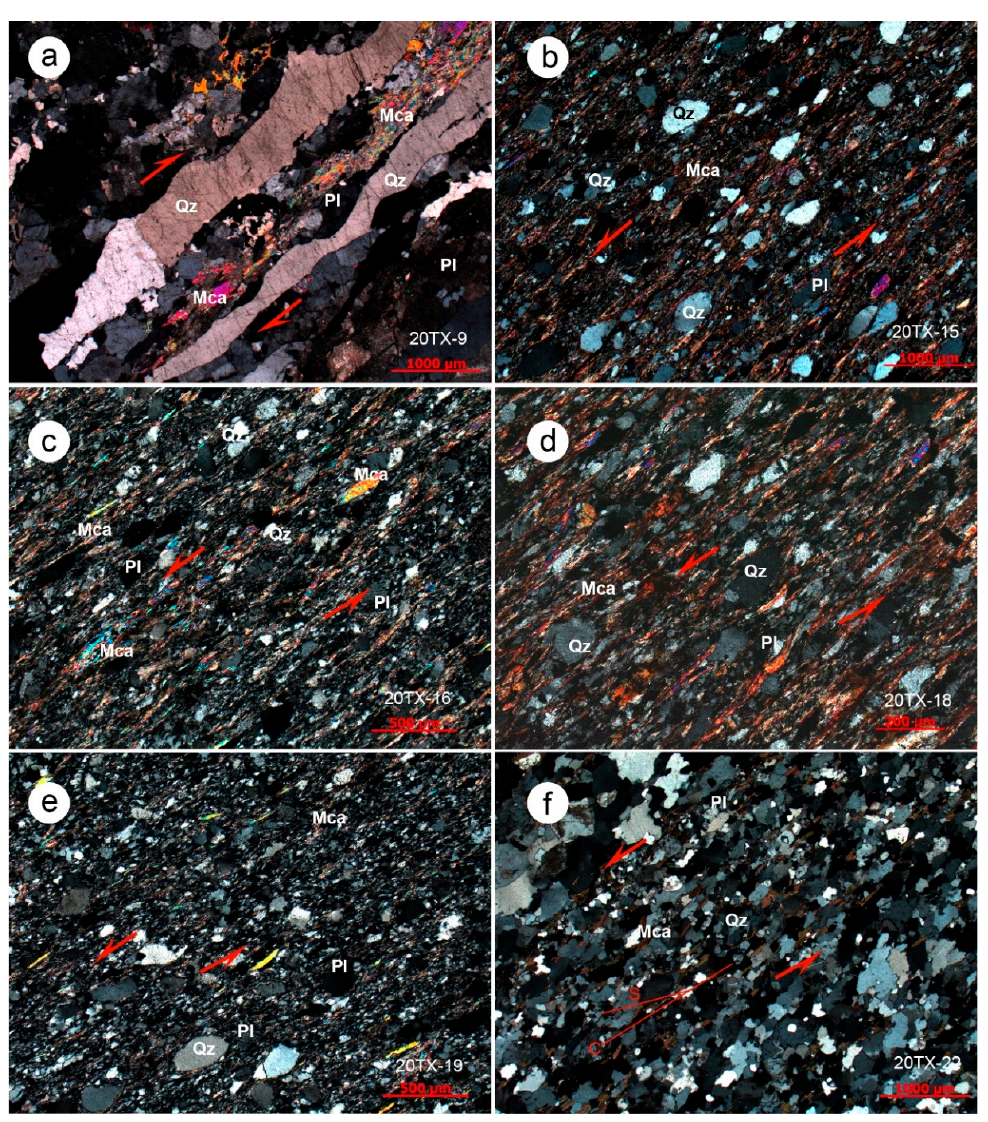
Figure 8. Photomicrographs of the deformed rocks in Taoxi dome. ( a ) Sample 20TX-9 collected from the Wuping–Taoxi shear zone. Note the strong elongated quartz grains and the strong alignment of